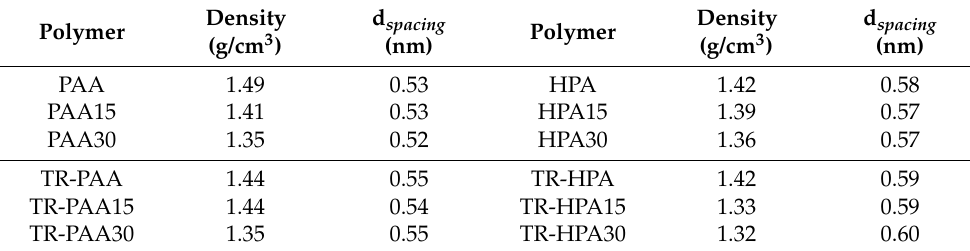
Figure 6. Diffractogram of MMMs and their corresponding TR from APAF-6FpDA-6FCl ( A ) and APAF-APA-6FCl ( B ). Table 3. Comparison of density and d spacing for